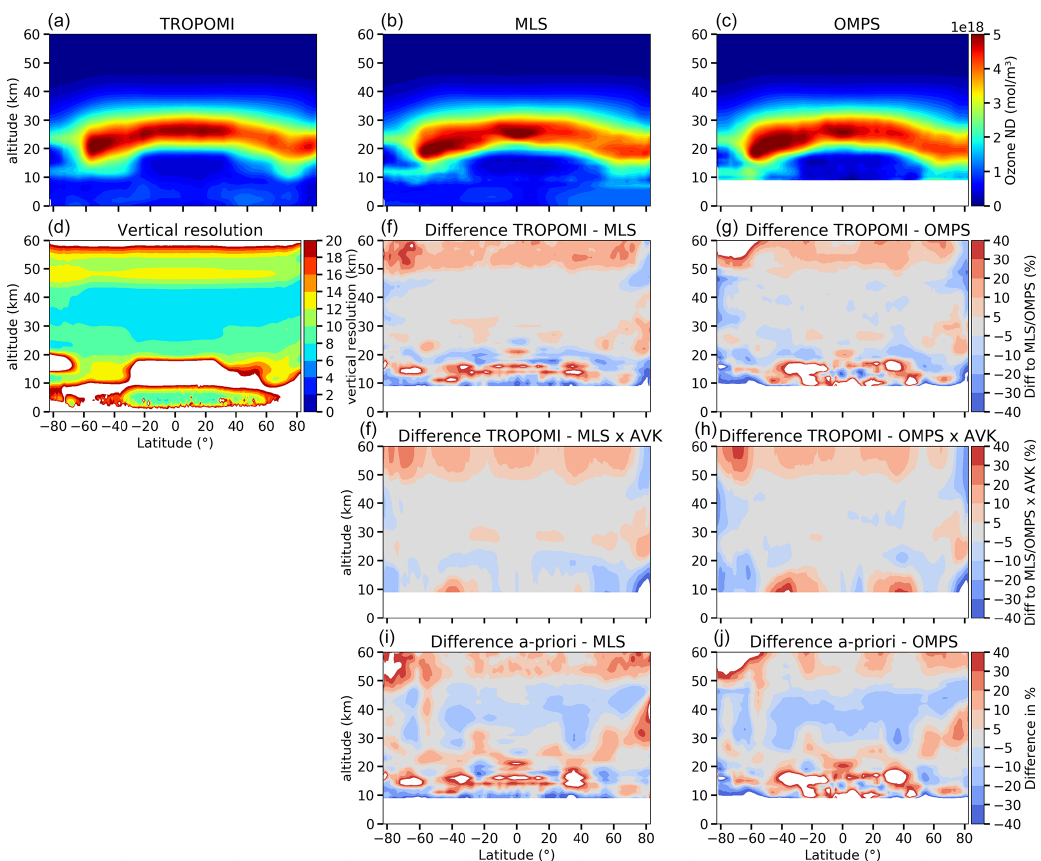
Figure 12. (a–c) The zonal mean ozone number density vertical distribution from TROPOMI (a) , MLS (b) , and OMPS (c) for 1 October 2018. (d) The mean vertical resolution of the TROPOMI retrieval. (e) The relative mean difference between TROPOMI and MLS results. (f) The relative mean difference between TROPOMI and OMPS results. (g, h) Same as (e) and (f) but for MLS and OMPS data convolved with TOPAS averaging kernels. (i, j) Relative mean difference between the TOPAS a priori ozone profiles (climatology) and MLS (i) or OMPS (j) measurements.